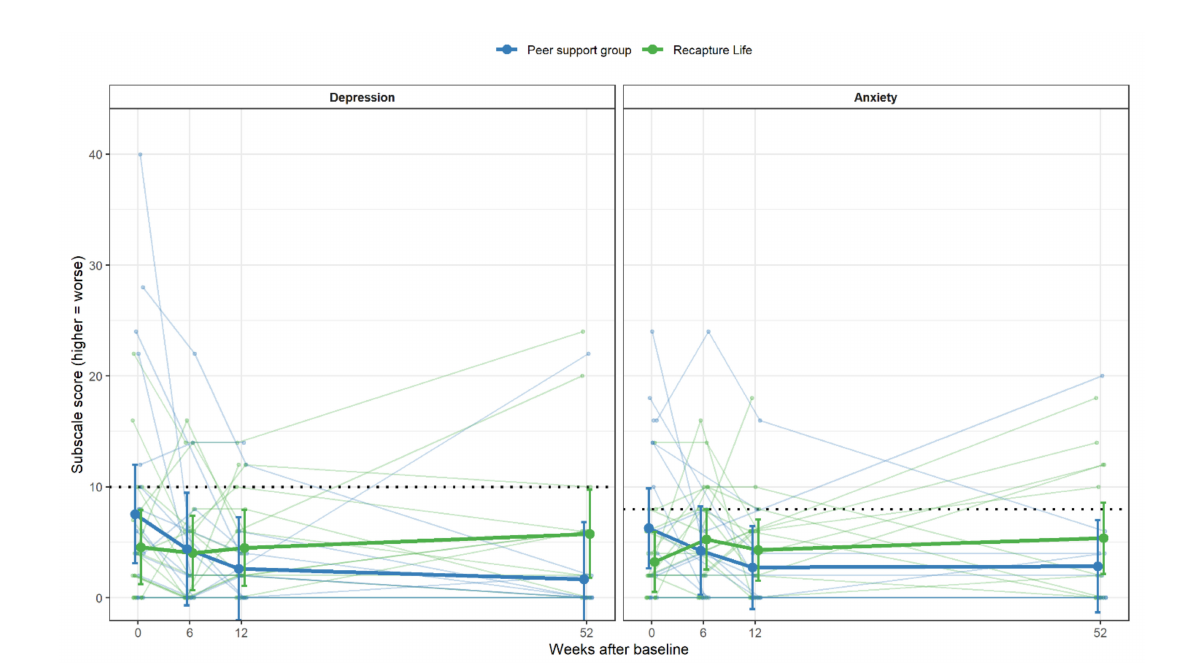
Figure 3. Depression and anxiety symptoms between Recapture Life and peer-support groups over time. Note. Individual scores are displayed, overlaid with thicker lines showing group-specific means and 95% confidence intervals. Dotted line indicates the upper end of ‘Normal’ range of symptoms on each subscale, with scores above this indicating Mild symptoms and